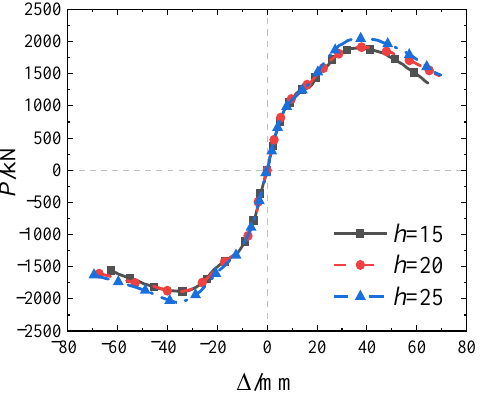
Figure 22. Load – displacement skeleton curves for models with different RCFSTK unit height. Figure 22. Load–displacement skeleton curves for models with different RCFSTK unit